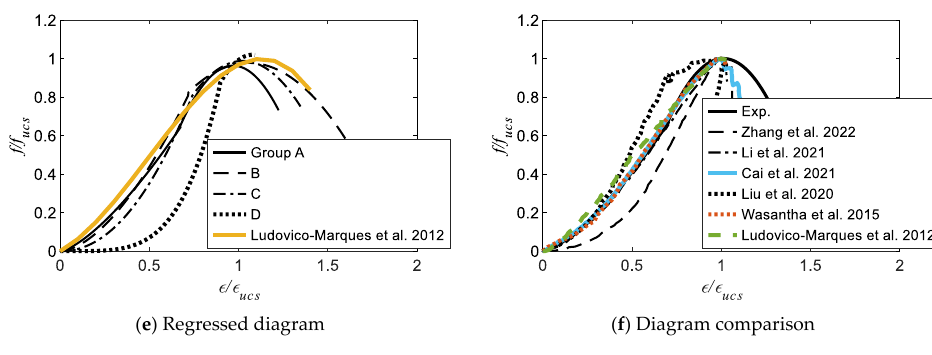
Figure 8. Diagram regression. Table 5. Parameters of the regressed diagrams.